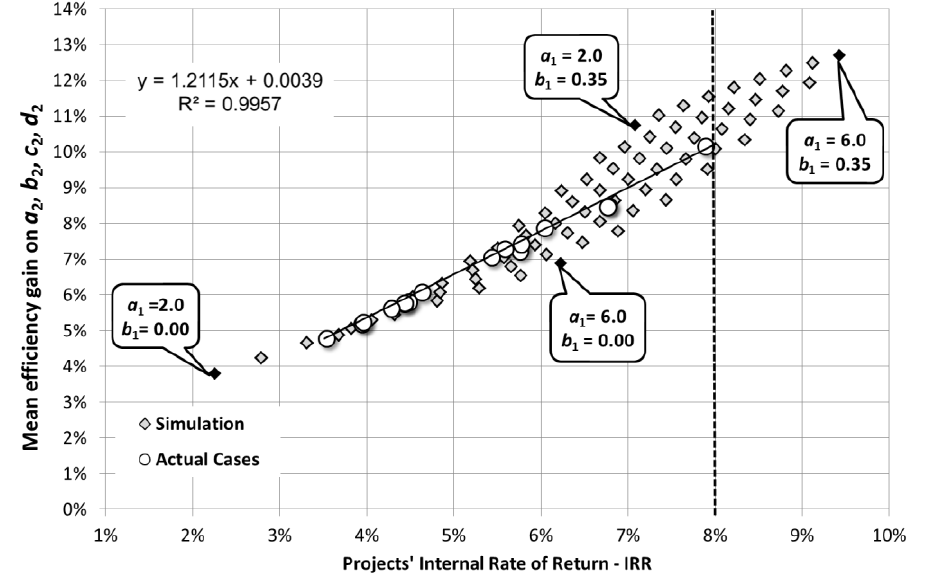
Figure 9. Mean gain in efficiency of the swing point and projects’